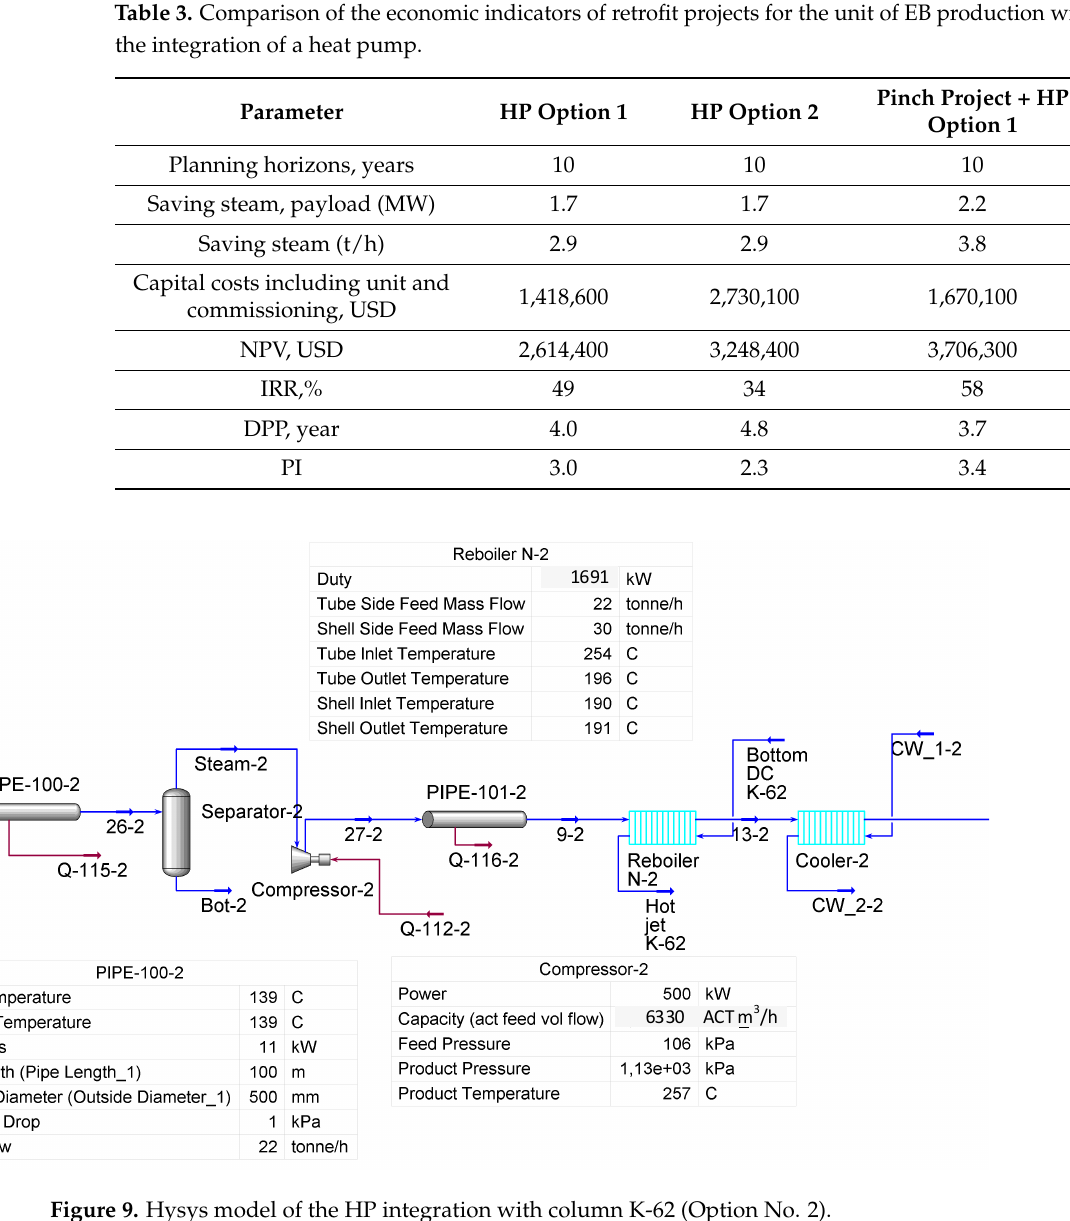
Figure 10. Schematic diagram of operation compression system for the HP integration in the first case. Note that when implementing any of the projects for integrating the heat pump with the EB production process, the steam savings will be more than three times greater than with the Pinch integration. At the same time, in all cases, the thermal potential of the hel- met vapor of the K-62 column is used to increase the heat recuperation capacity. The ca- pacity that is released during the condensation of these vapors is sufficient for simultane- ous use for both Pinch integration and heat pump integration. Therefore, we can consider joint Pinch integration and heat pump integration not as a complex solution, but as a step- by-step solution. Step-by-step retrofit of HEN systems is more acceptable at existing en- terprises. Therefore, we can combine Pinch integration with heat pump integration in the first option. Hysys model of such a solution is shown in Figure 11.